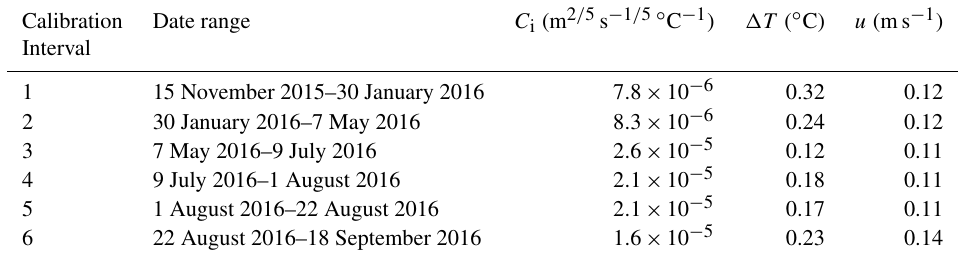
Table 2. Calibrated values for C i for the individual calibration intervals associated with each measured change in ice thickness. The corre- sponding mean driving temperature ( (cid:49)T ) and velocity ( u ) values, found with the CMEMS data, are also provided.